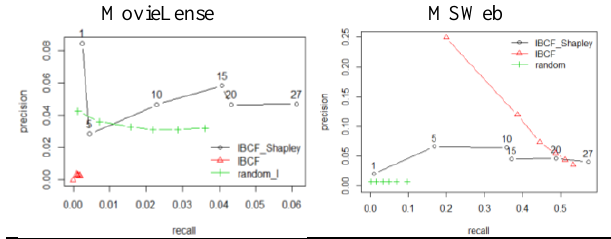
Figure 9. Recision/Recall of three